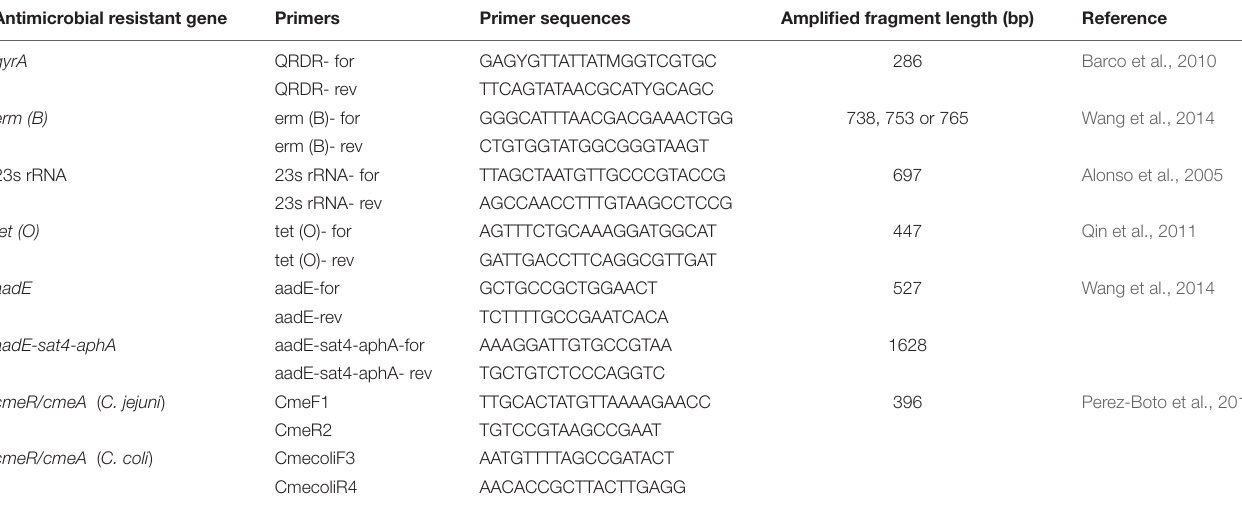
cmeR/cmeA ( C. coli )